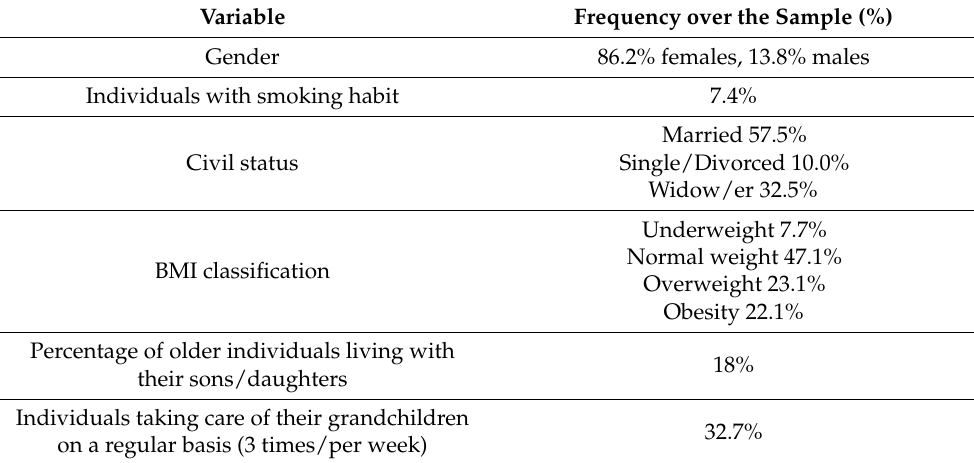
Table 1. Characteristics of the study